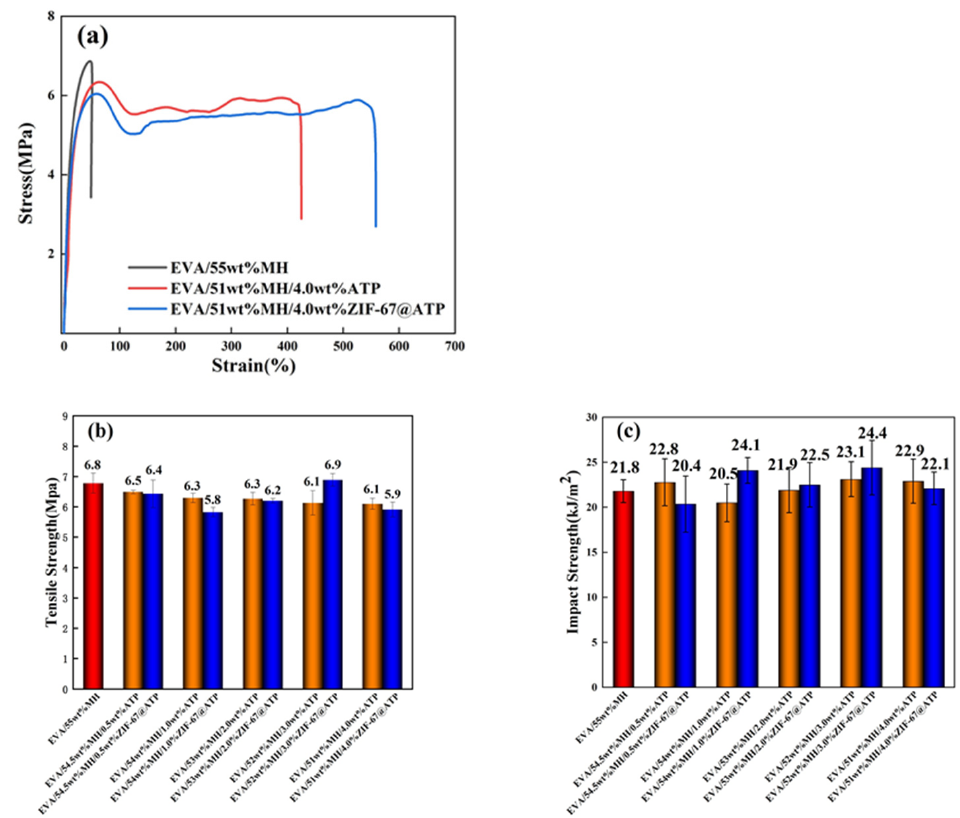
Figure 7. ( a ) Stress–strain curve of the EVA composites; ( b ) tensile strength; ( c ) non-notched impact strength of EVA/MH/ATP composites and EVA/MH/ZIF-67@ATP Table 4. Mechanical properties data of EVA and EVA composites.